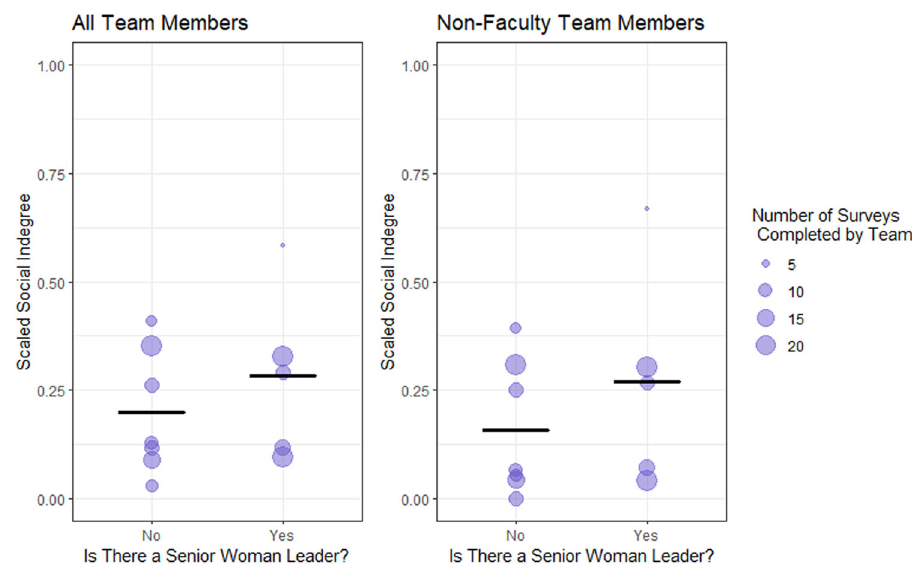
Fig. 4 The average scaled indegree in the social network was computed for each team and the nonfaculty on a team. These average scaled indegree measures were then separated based on whether there was a senior woman leader on the team, and the average across all teams was marked by a black horizontal bar. Based on these data, there appears to be no systematic difference in the social interactions of teams with a woman in a senior position and teams without a woman in a senior position. Average scaled indegree of non-faculty on teams without a senior woman = 0.16. Average scaled indegree of non-faculty on teams with a senior woman = 0.27. ( t -test) p -value =